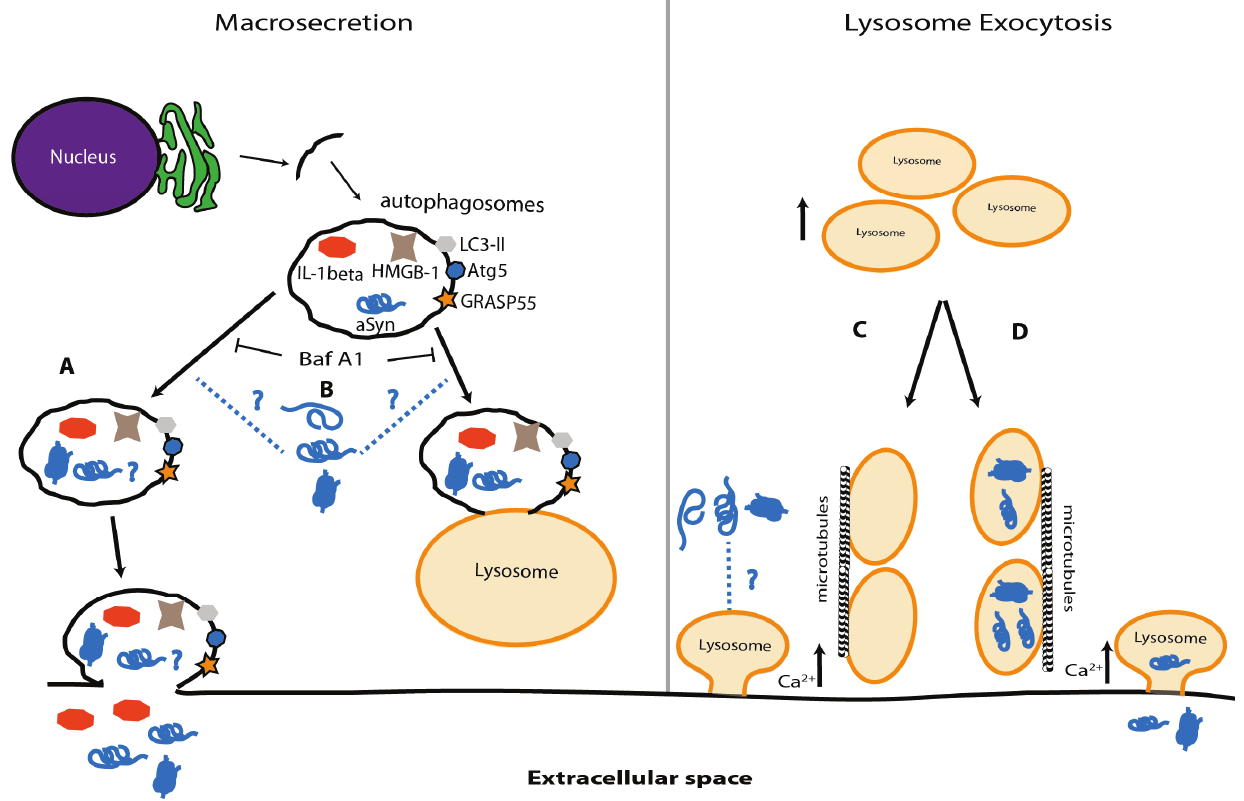
Figure 4. Macrosecretion and lysosome-mediated exocytosis. ( A ) Since autophagosomes can be secreted to the extracellular space, it is possible that (cid:2)-syn release occurs via this pathway, both in normal conditions and upon autophagosome accumulation due to lysosome impairment; ( B ) (cid:2)-syn can alter the levels of important players in macroautophagy and eventually play a role in macrosecretion; ( C ) Lysosomes can fuse with the plasma membrane and release their content, a mechanism named lysosome exocytosis. The process is similar to the one observed in neurotransmitter release, (cid:2)-syn may play a role; ( D ) Alternatively, impairment of protein degradation might promote the accumulation of high molecular weight species of (cid:2)-syn inside the lysosome. One can speculate that, as observed in LSDs, the lysosomes might fuse with the plasma membrane and release (cid:2)-syn oligomers and aggregates into the extracellular media and start the propagation of